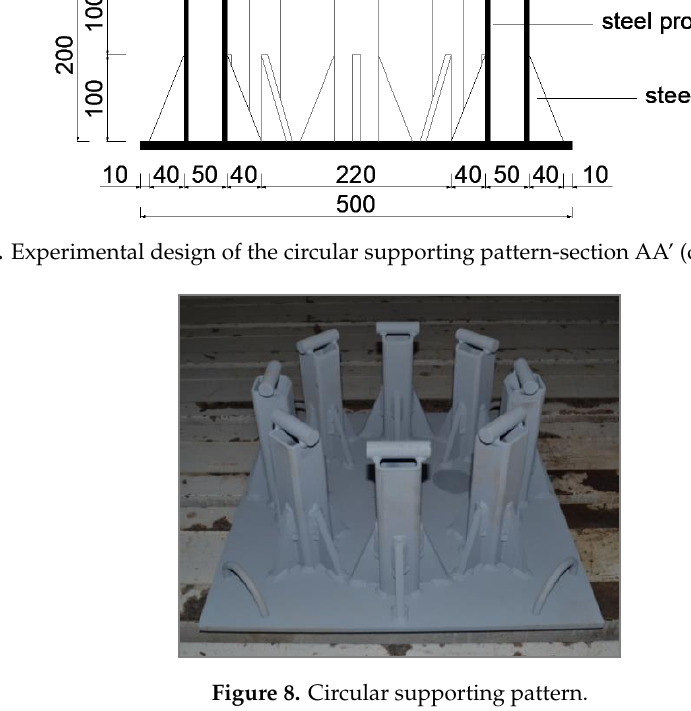
Figure 8. Circular supporting pattern.